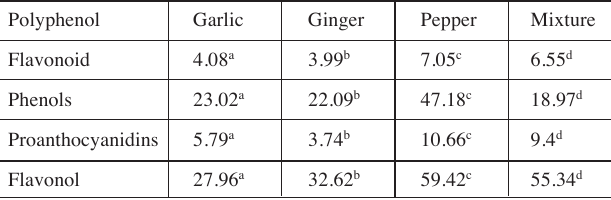
Tab. 1: Total flavonoid, phenolic, proanthocyanidin and flavonol content of extracts of, garlic, gingers, pepper and their mixture (mg/ml)